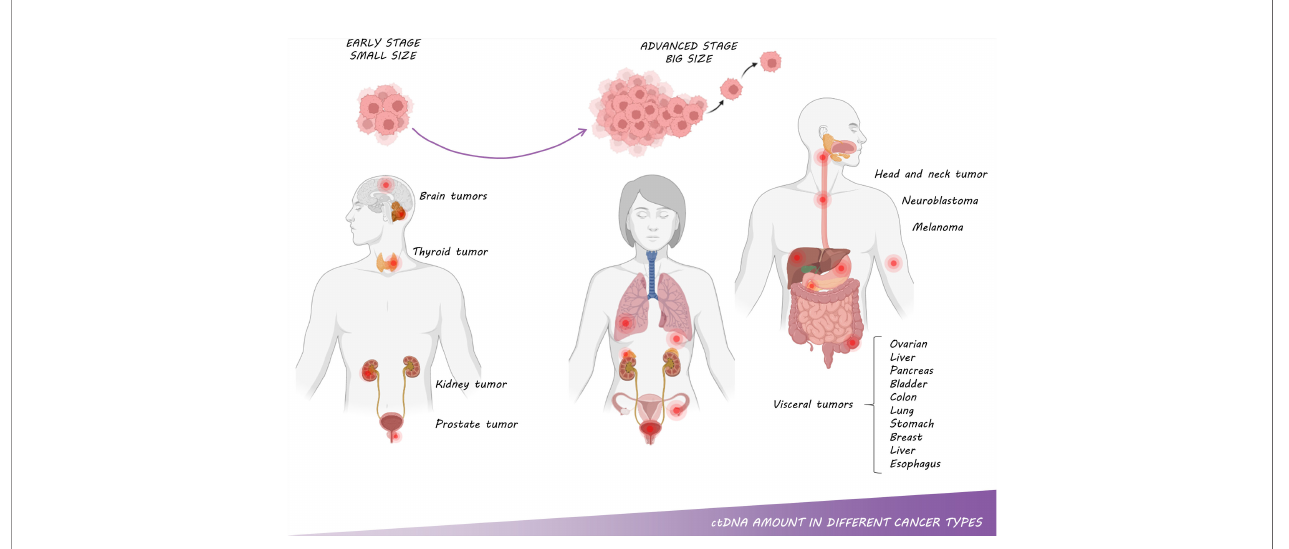
FIGURE 5 | ctDNA amount in different cancer types: The amount of ctDNA is correlated with tumor type, size, stage and